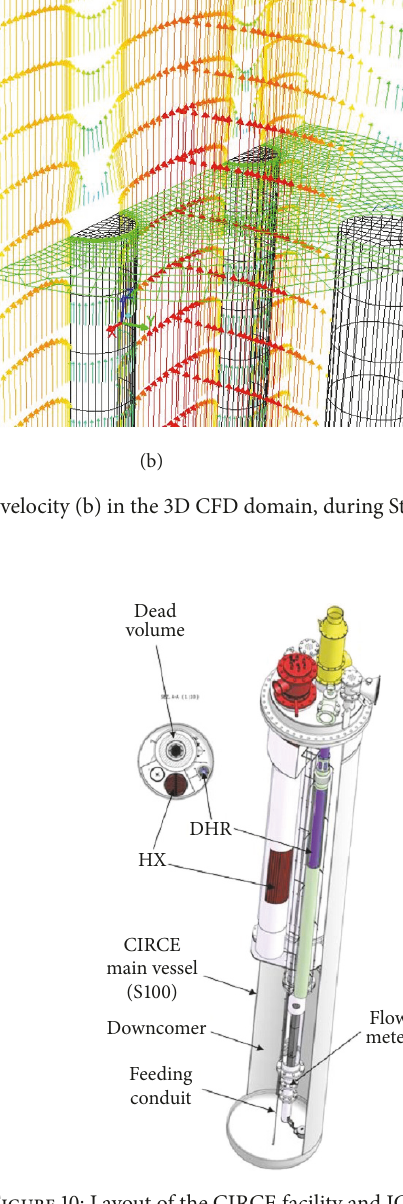
Figure 10: Layout of the CIRCE facility and ICE test